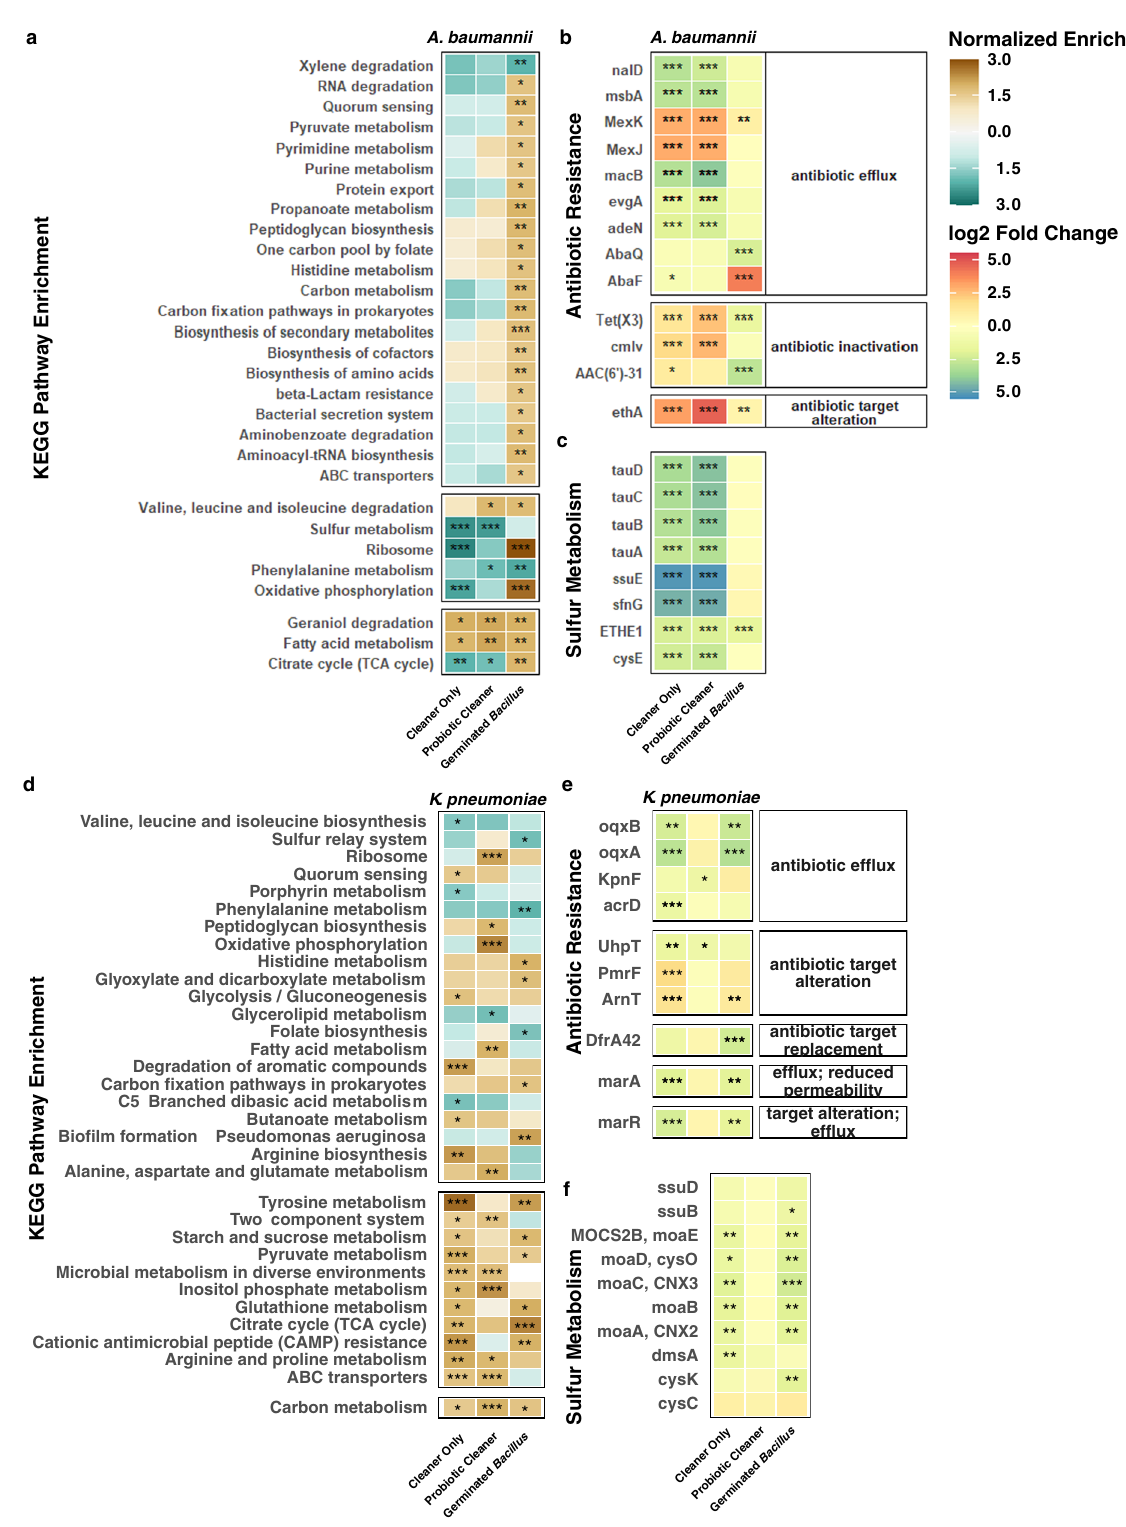
Fig. 4 Variations in functional pathways in pathogens on surfaces under ambient conditions based on transcriptomics. KEGG pathway enrichment results for samples collected under ambient temperature and humidity condition ( a , d ), log 2 fold change of genes associated with antibiotic/antimicrobial resistance ( b , e ), and sulfur metabolism ( c , f ), compared to no-cleaning samples ( A. baumannii or K. pneumoniae ). KEGG pathways shown here were statistically enriched in at least one of the cleaning conditions (Benjamini-Hochberg corrected p value ≤ 0.05). Normalized enrichment score (NES) accounts for differences in gene set size and were used to compare enrichment results across KEGG pathways; a positive NES suggests an overall positive upregulation of genes belonging to its corresponding pathway 70 – 72 . * p < 0.05, ** p < 0.01, and *** p <